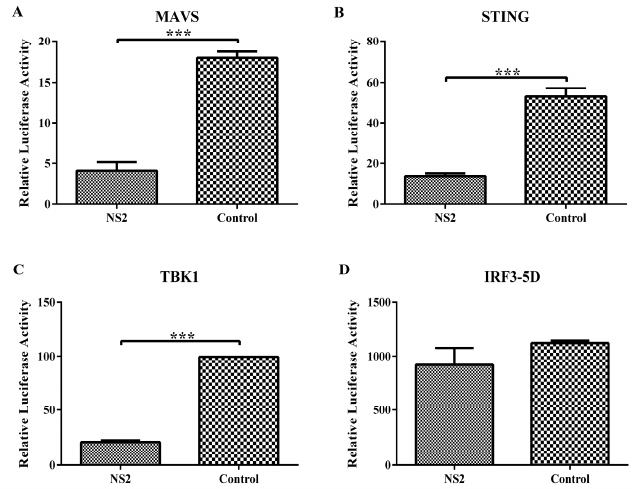
Figure 4. FPV NS2 blocks interferon induction at a step upstream of IRF3. F81 cells were co-transfected